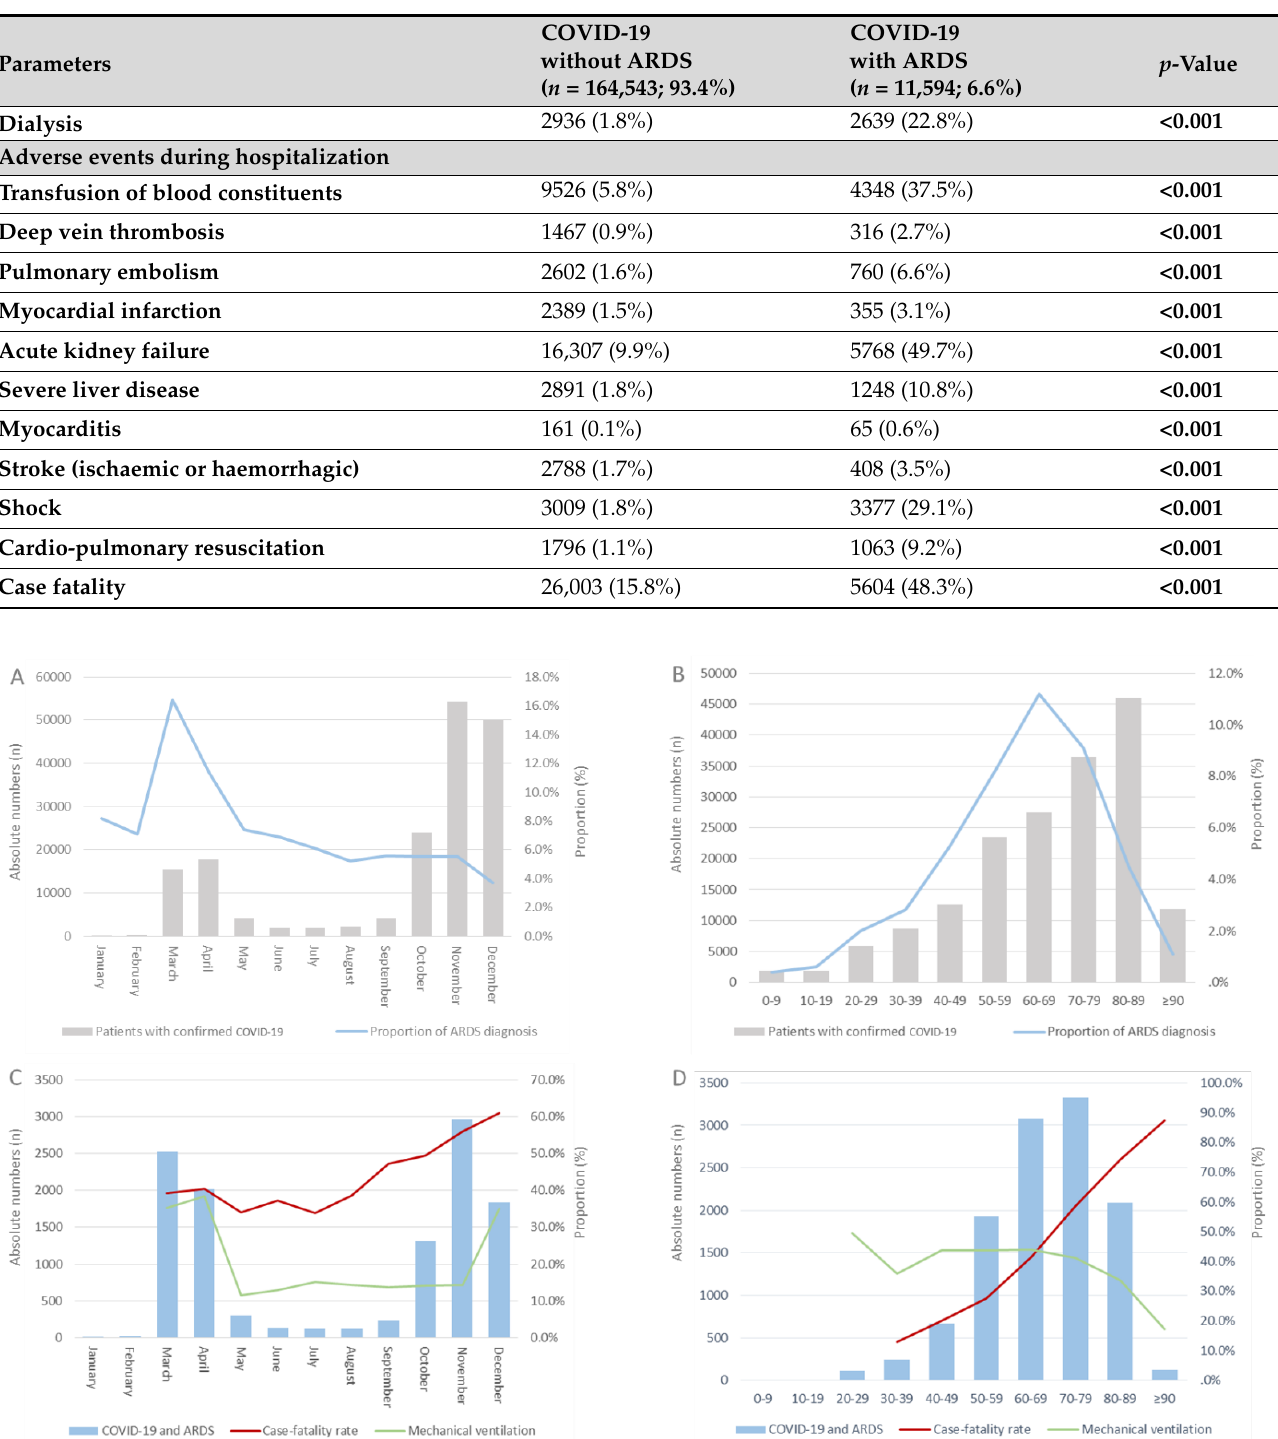
Figure 1. Proportion rate of ARDS diagnosis in patients with COVID-19 across months ( A ) and age decades ( B ). Case-fatality rate and proportion of mechanical ventilation in patients with COVID-19 and ARDS across months ( C ) and age decades ( D ) in Germany in 2020.